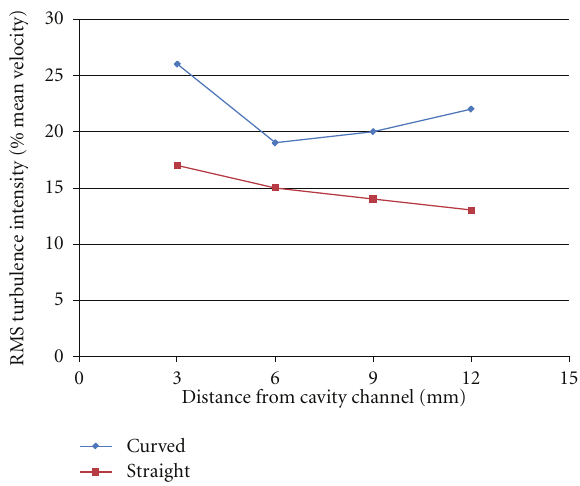
Figure 20: RMS average turbulence intensity over the depth of the main channel.